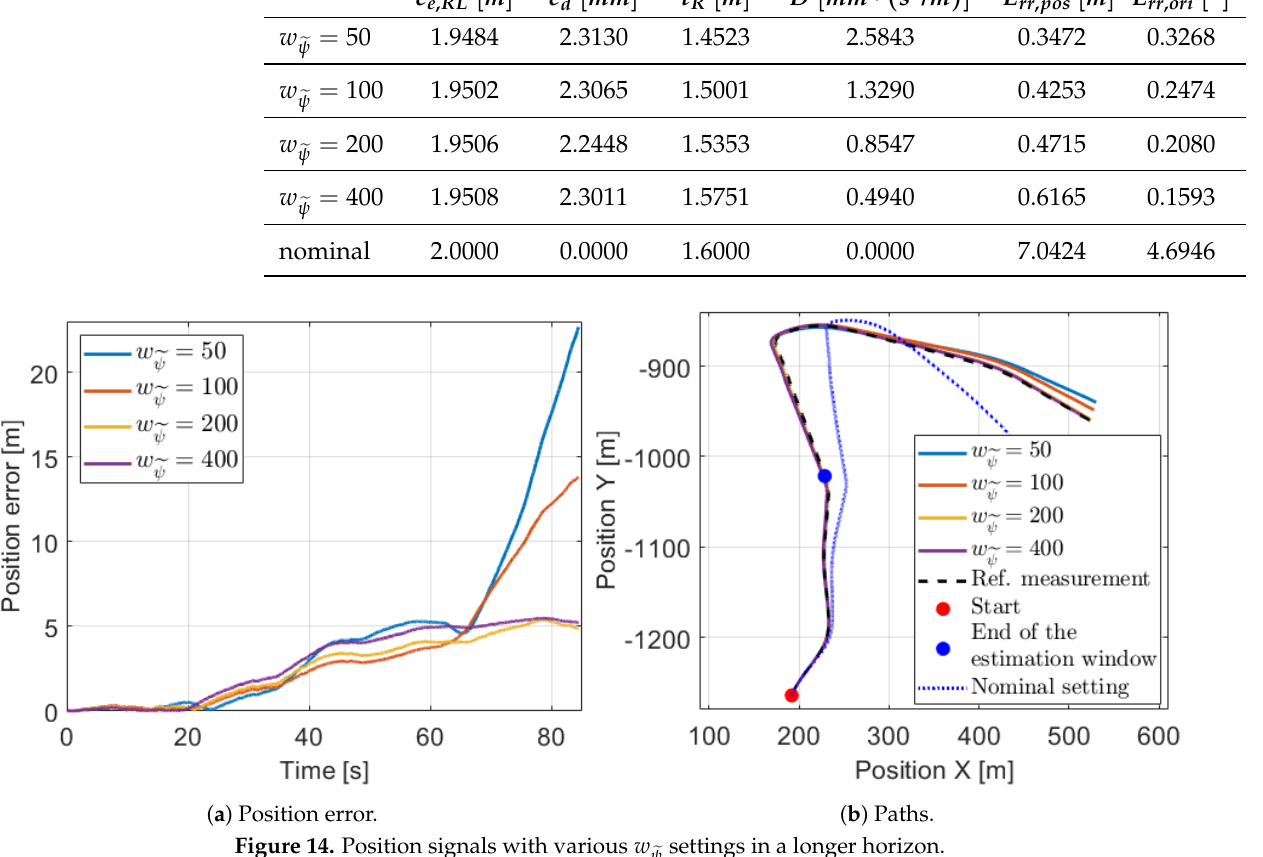
settings in a longer (cid:101) ψ